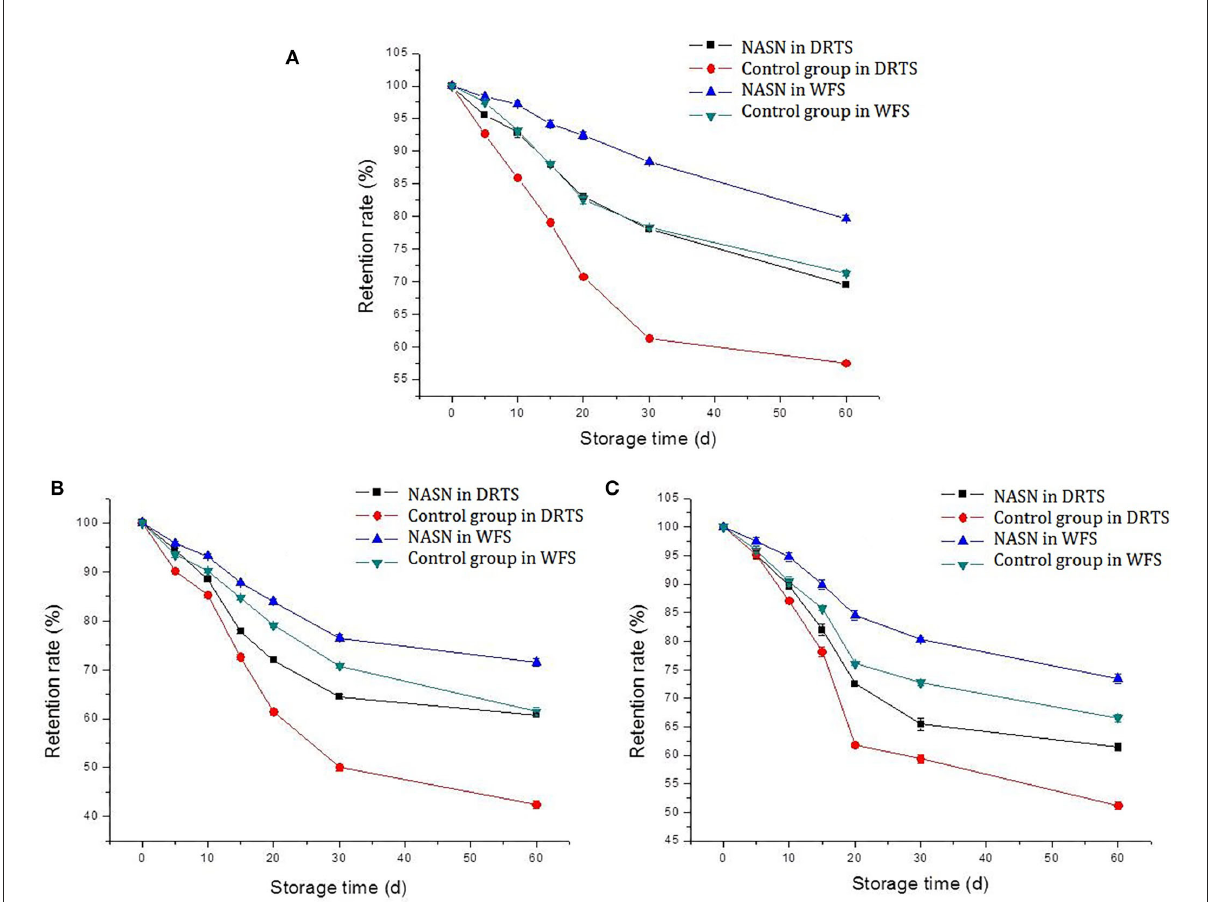
FIGURE6 Retention rate changing of curcumin (A) , TP (B) , and lycopene (C) in NASNs and the control group in the condition of DRTS and WFS.